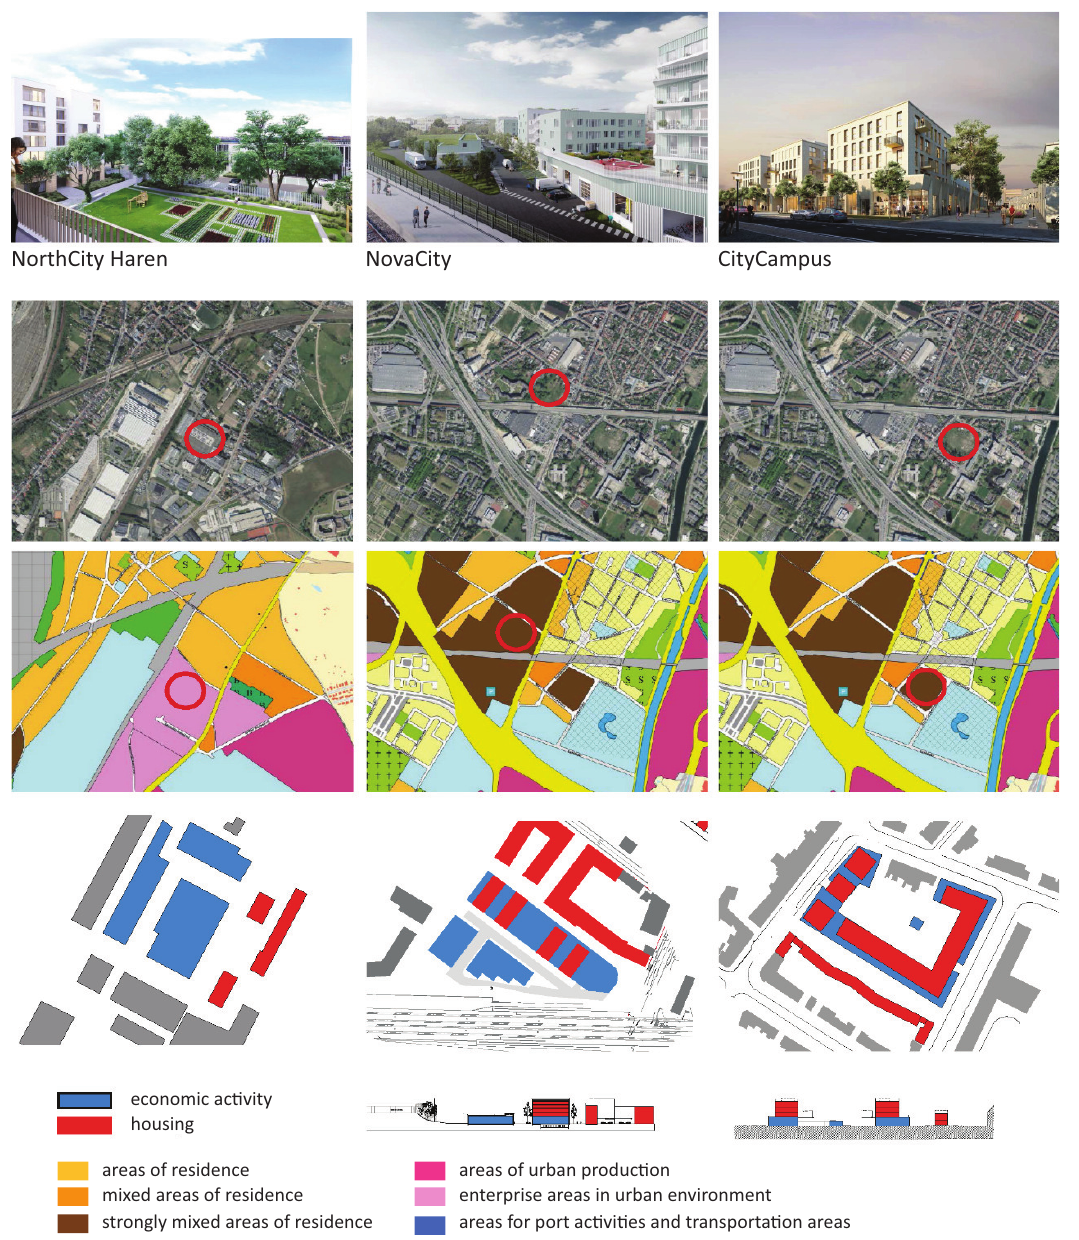
Figure 4. Renderings, spatial context, land use, and spatial lay out of three live‐work mix projects in the Brussels Capital Region. Sources: Binst Architects and ORG permanent modernity (n.d.); BruGIS Team (n.d.); Pixelab (n.d.); Urban Nation Architects & Associates (n.d.). Spatial lay out drawn by Jan Zaman based on citydev.brussels (2018, 2019) and Futurn